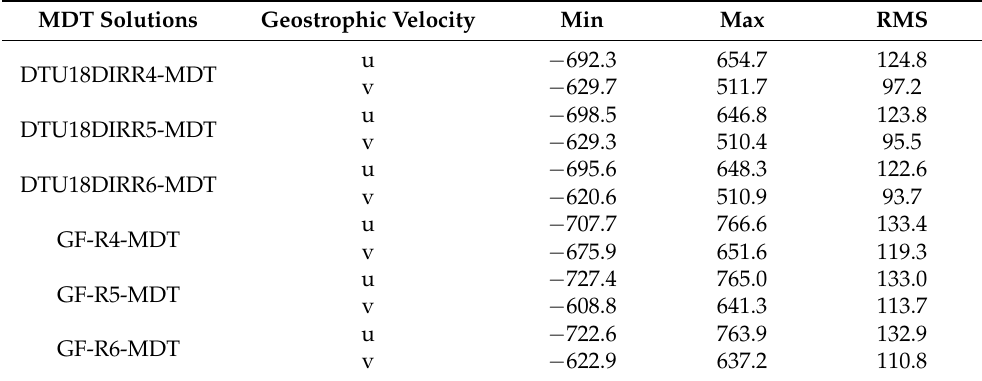
Table 8. Statistics of the differences in the geostrophic velocities between the buoy data and the information deduced from the MDT solutions (units: